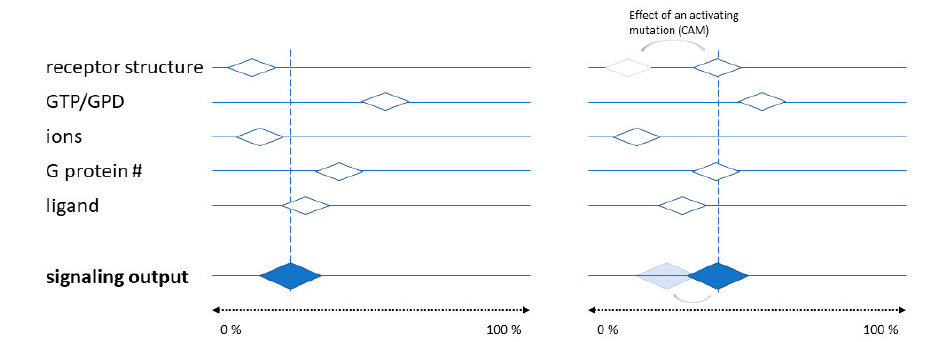
Figure 2. Ligand efficacy as one of many determinants of the signaling output. A number of effects determine the signaling output (e.g., the receptor structure, GTP/GDP ratio, ion concentrations, number of G proteins, and ligand binding) ( left ). The apparent property of a ligand as an inverse agonist, neutral antagonist, and agonist can only be determined relative to the overall output level. For example, introducing a constitutively active mutant (CAM) into the receptor structure may change a ligand’s effect from weak partial agonism to inverse agonism ( right ).